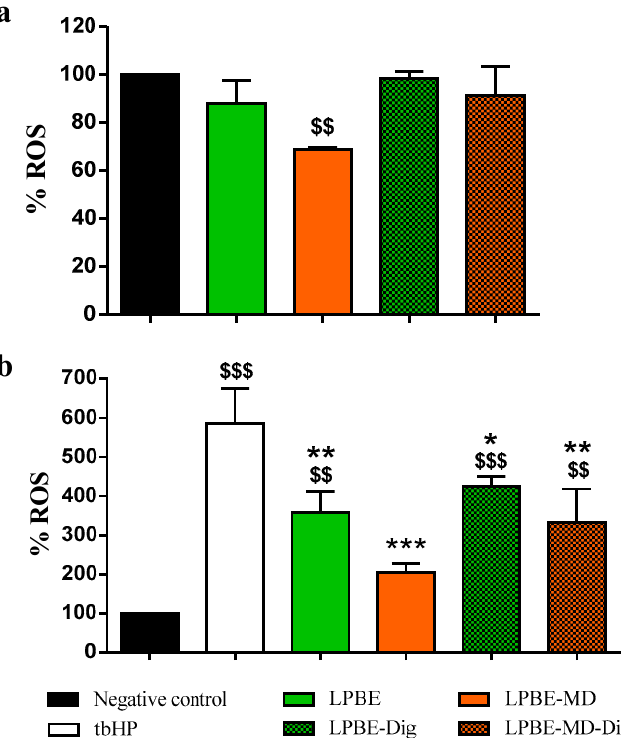
Figure 5. Antioxidant activity of extracts on Caco-2 cells. ( a ) Measurement of reactive oxygen species levels after 8 h incubation with 500 µ g extract /mL of encapsulated/non-encapsulated (digested and undigested extracts). ( b ) Measurement of reactive oxygen species levels after 8 h incubation with 500 µ g extract /mL of encapsulated/non-encapsulated (digested and undigested extracts) and further tert-butyl Hydrogen Peroxide insult (1h incubation with 100 mM tbHP). Values are expressed as mean ± SD of three experiments. $$ p < 0.01, $$$ p < 0.001 versus control cells, and * p < 0.05, ** p < 0.01, *** p < 0.001 versus tbHP-treated cells.